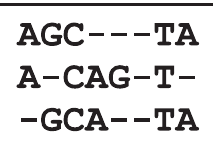
Figure 1. A Multiple Alignment of AGCTA, ACAGT, and